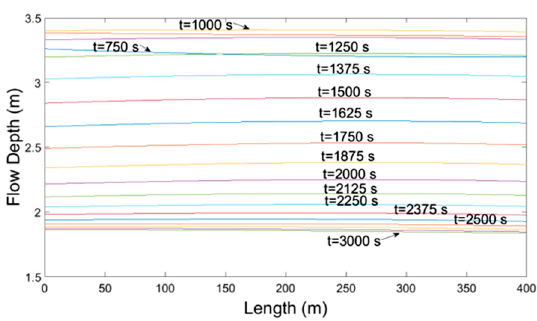
Figure 21. Flow Depth-Distance at various